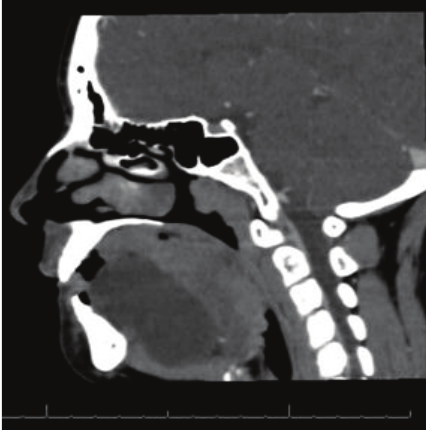
Figure 2: CT image demonstrating tracheal compression secondary to a large expanding